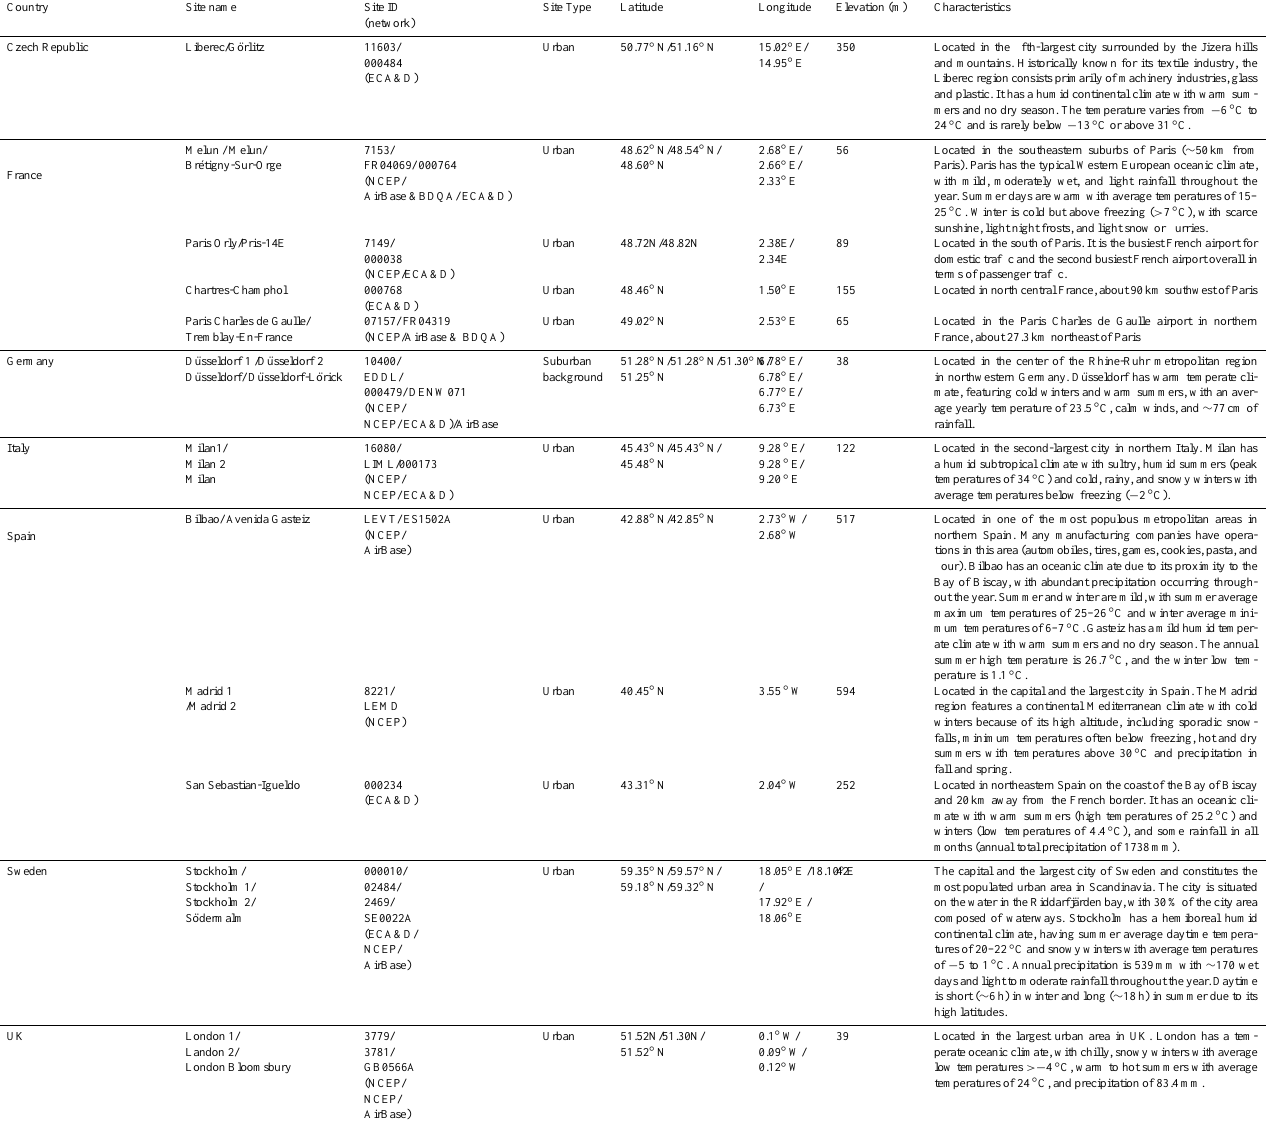
Table 5. Characteristics of sites selected for temporal analysis.